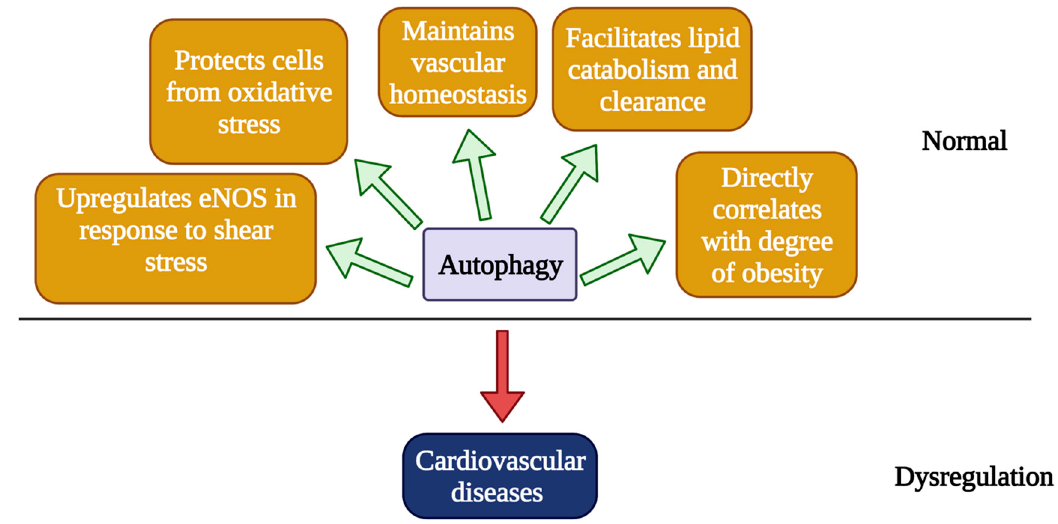
Figure 2. Roles of autophagy in the pathobiology of cardiovascular diseases. Autophagy is essential for regulating endothelial functions to maintain vascular homeostasis. Autophagy plays an important role in lipid clearance, and impaired autophagy leads to the accumulation of lipid, which is a known risk factor for the development of atherosclerosis. Mitophagy can protect vascular ECs from oxidative stress by removing damaged mitochondria and by preventing the elevation of ROS. Shear stress in the vessel wall can induce autophagy, which resulted in reduced ROS and increased NO production, mainly by upregulating eNOS and increased cell viability. Autophagy correlates with the level of obesity, a major risk factor for developing CVDs. Dysregulated autophagy can lead to CVDs, which will be discussed in detail in the next section.